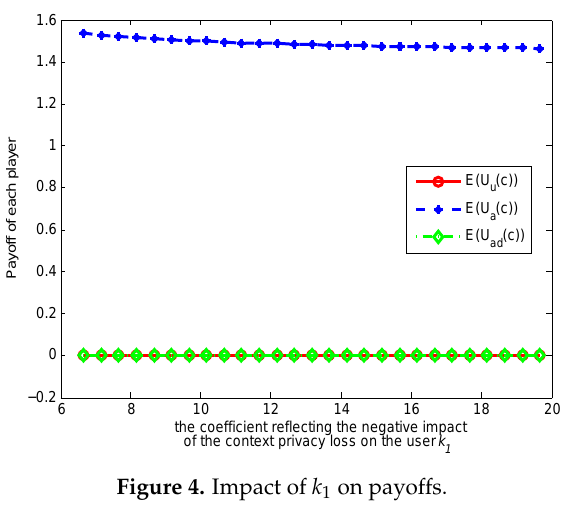
Figure 4. Impact of k 1 on payoffs.